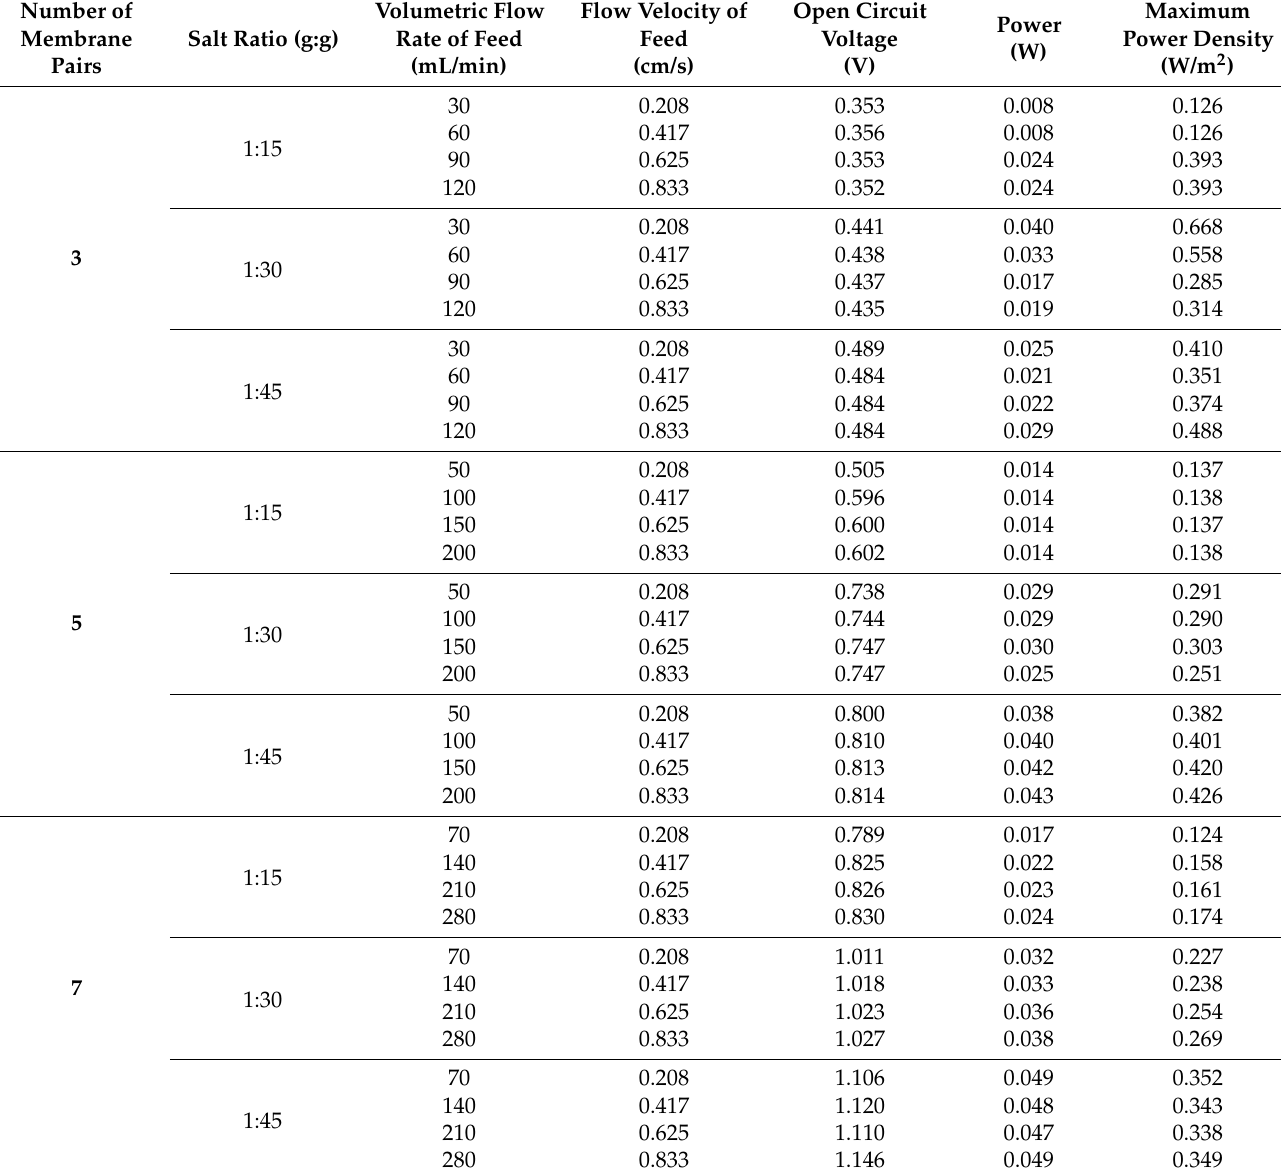
Table 4. Open circuit voltage, power and power density results for all parameters. Number